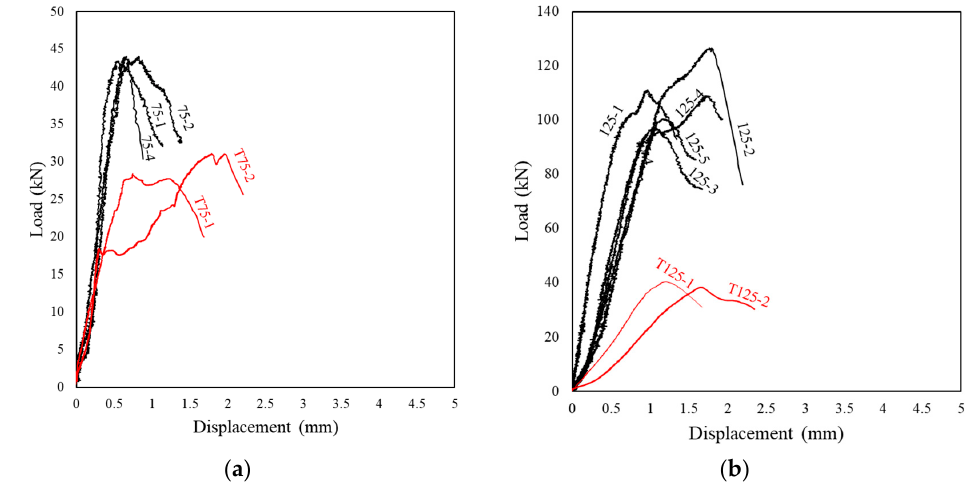
Figure 12. Load–displacement curves for: ( a ) h ef = 75 mm and ( b ) h ef = 125 mm. For the 75 mm anchors, which all experienced concrete cone failure, the load–dis- placement curves show a first linear phase more or less overlapping for all the tests, whether at room or high temperature. Then, at high temperature, this phase is followed by a second non-linear phase, where the slope of the load–displacement curve decreases. The behaviors of the two anchors were different in this non-linear phase, resulting in dif- ferent displacements despite quite similar peak loads.